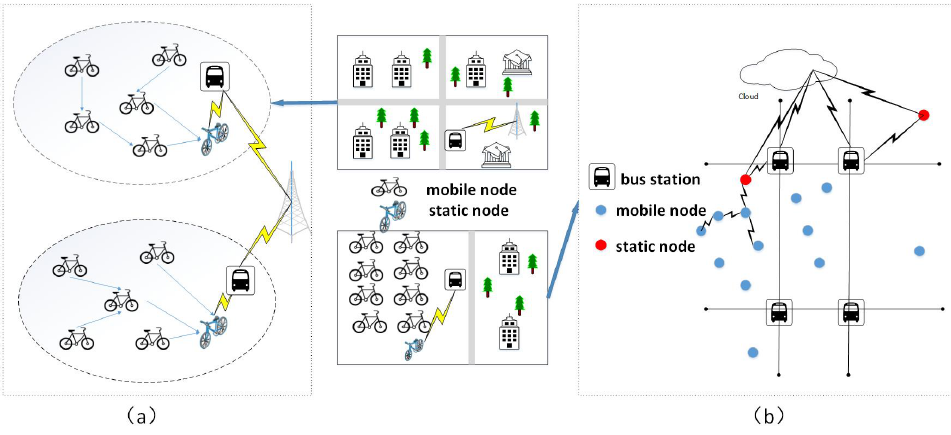
Figure 10. Network deployment and work schematic of IoSB, ( a ) hierarchical clustering heterogeneous network; ( b ) topology structure of hierarchical clustering heterogeneous network